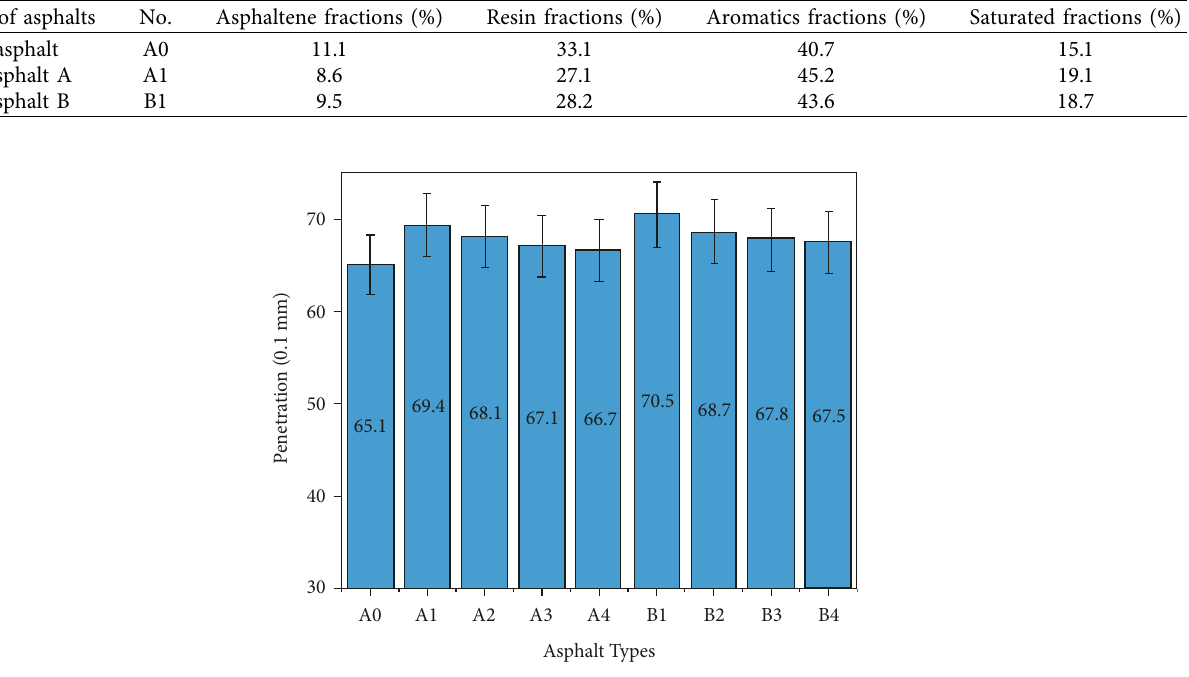
Figure 4: Effects of different GO dosages on the penetration of